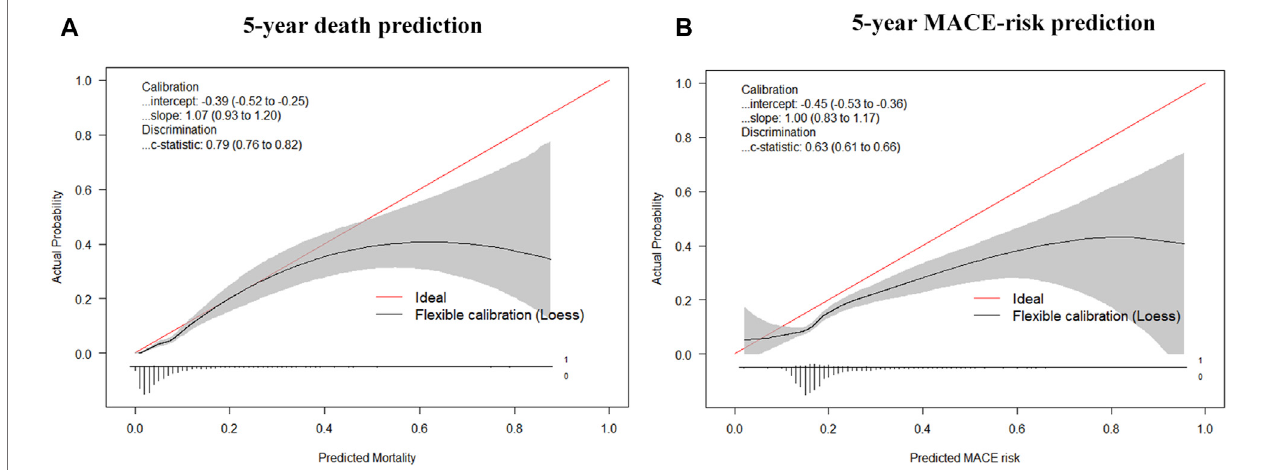
FIGURE6| Calibrationcurvesforthenomogrammodel. (A) Calibrationcurvesoftheprognosticnomogramfor5-yearsoverallsurvival; (B) Calibrationcurvesofthe nomogram predicting risk of MACE.